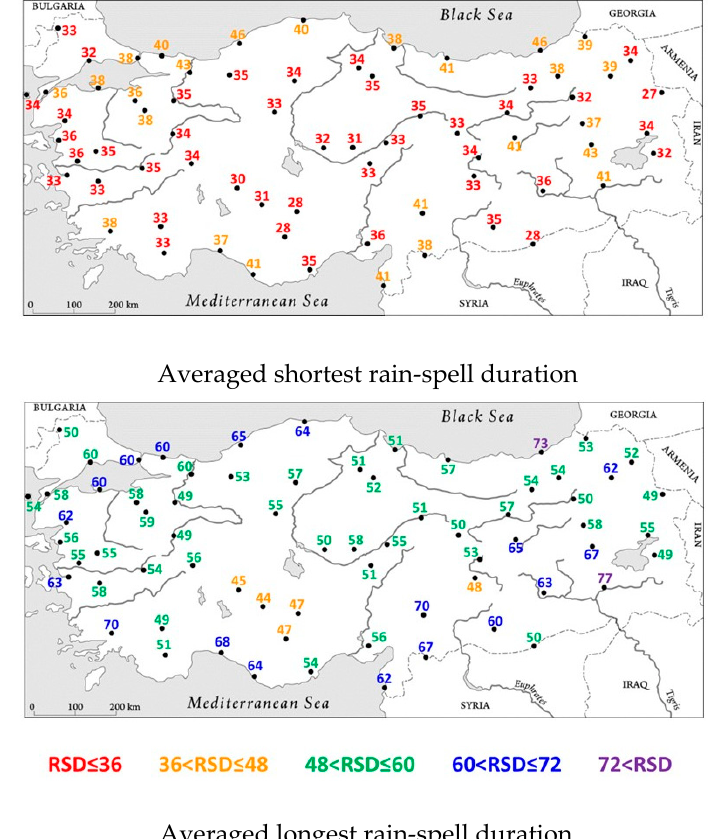
Figure 7. Mean annual rain-spell duration (RSD) in Turkey (1970–2011).